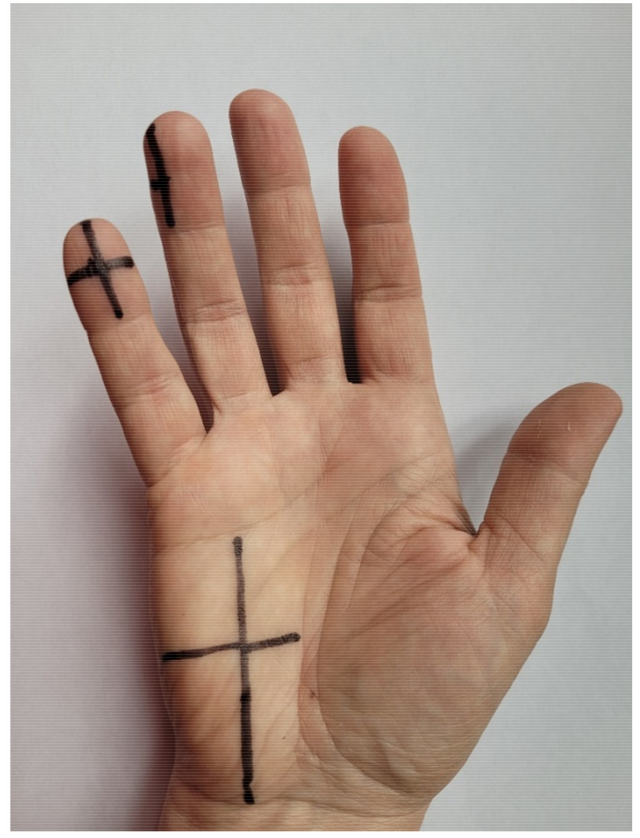
Figure 2. Longitudinal and transverse lines to standardize the